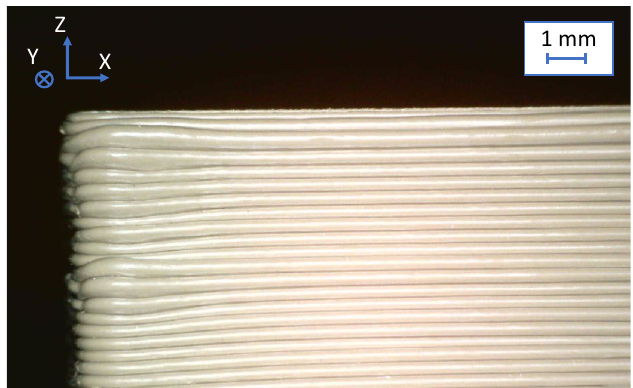
Figure 3. Surface topography of the as built part before milling.